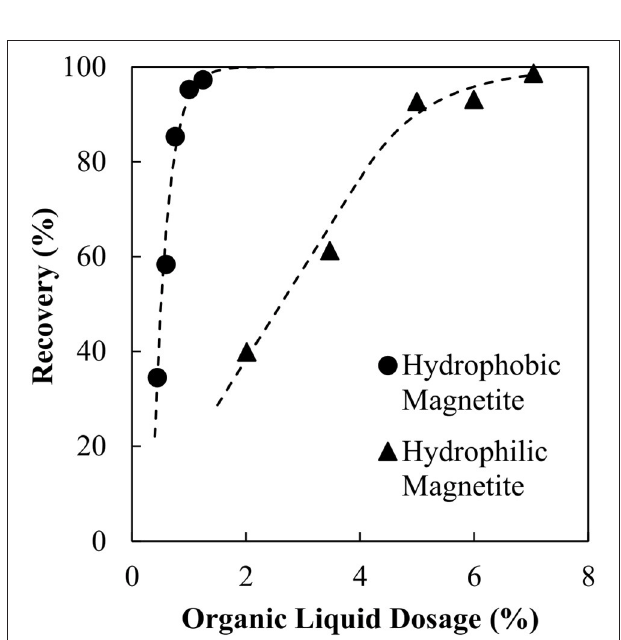
FIGURE 5 | Reduction in organic liquid requirement for conditioned magnetite